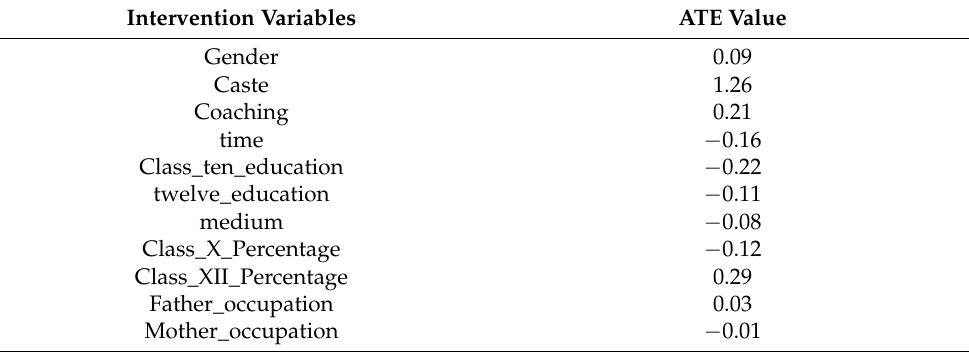
Table 11. ATE values between intervention and response variables based on